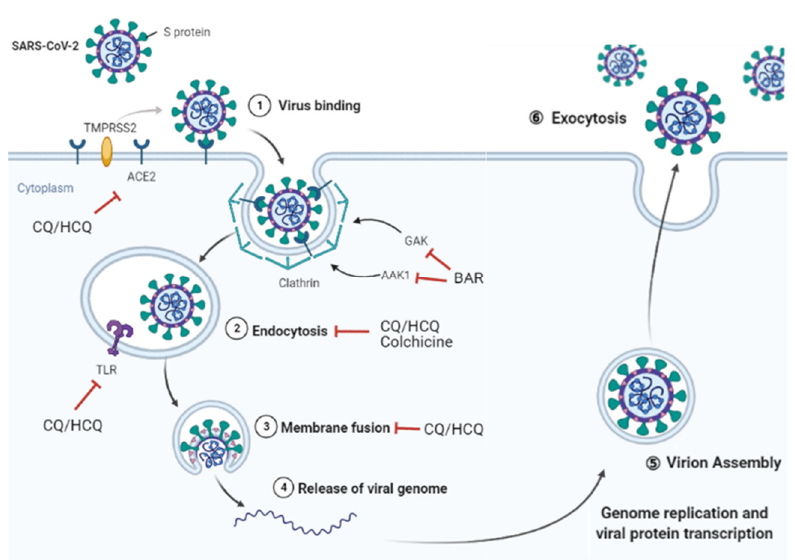
Figure 2. Overview of the mechanism of SARS-CoV-2 infection. The spike (S) protein on the surface of SARS-CoV-2 binds to ACE2 expressed on host cells, such as nasal and bronchial epithelial cells and pneumocytes. TMPRSS2 present on the host cell surface subsequently primes the S protein and promotes endocytosis-induced viral entry into the cell. The virus is carried into the endosome and uncoated by fusing with the endosome membrane, which releases its genomic RNA into the cytoplasm. Genomic RNA replication and protein synthesis occur in the ribosome, forming viral particles and releasing them extracellularly. Active viral replication activates various immune cells and produces large amounts of inflammatory cytokines. CQ and HCQ inhibits the glycosylation of ACE2, which may interfere with the binding of SARS-CoV-2 to the cell receptor. CQ and HCQ decrease acidity in endosomes and inhibit the fusion of SARS-CoV-2 to host cell membranes, and also interfere with TLR signaling by changing local pH. Colchicine may affect clathrin-mediated